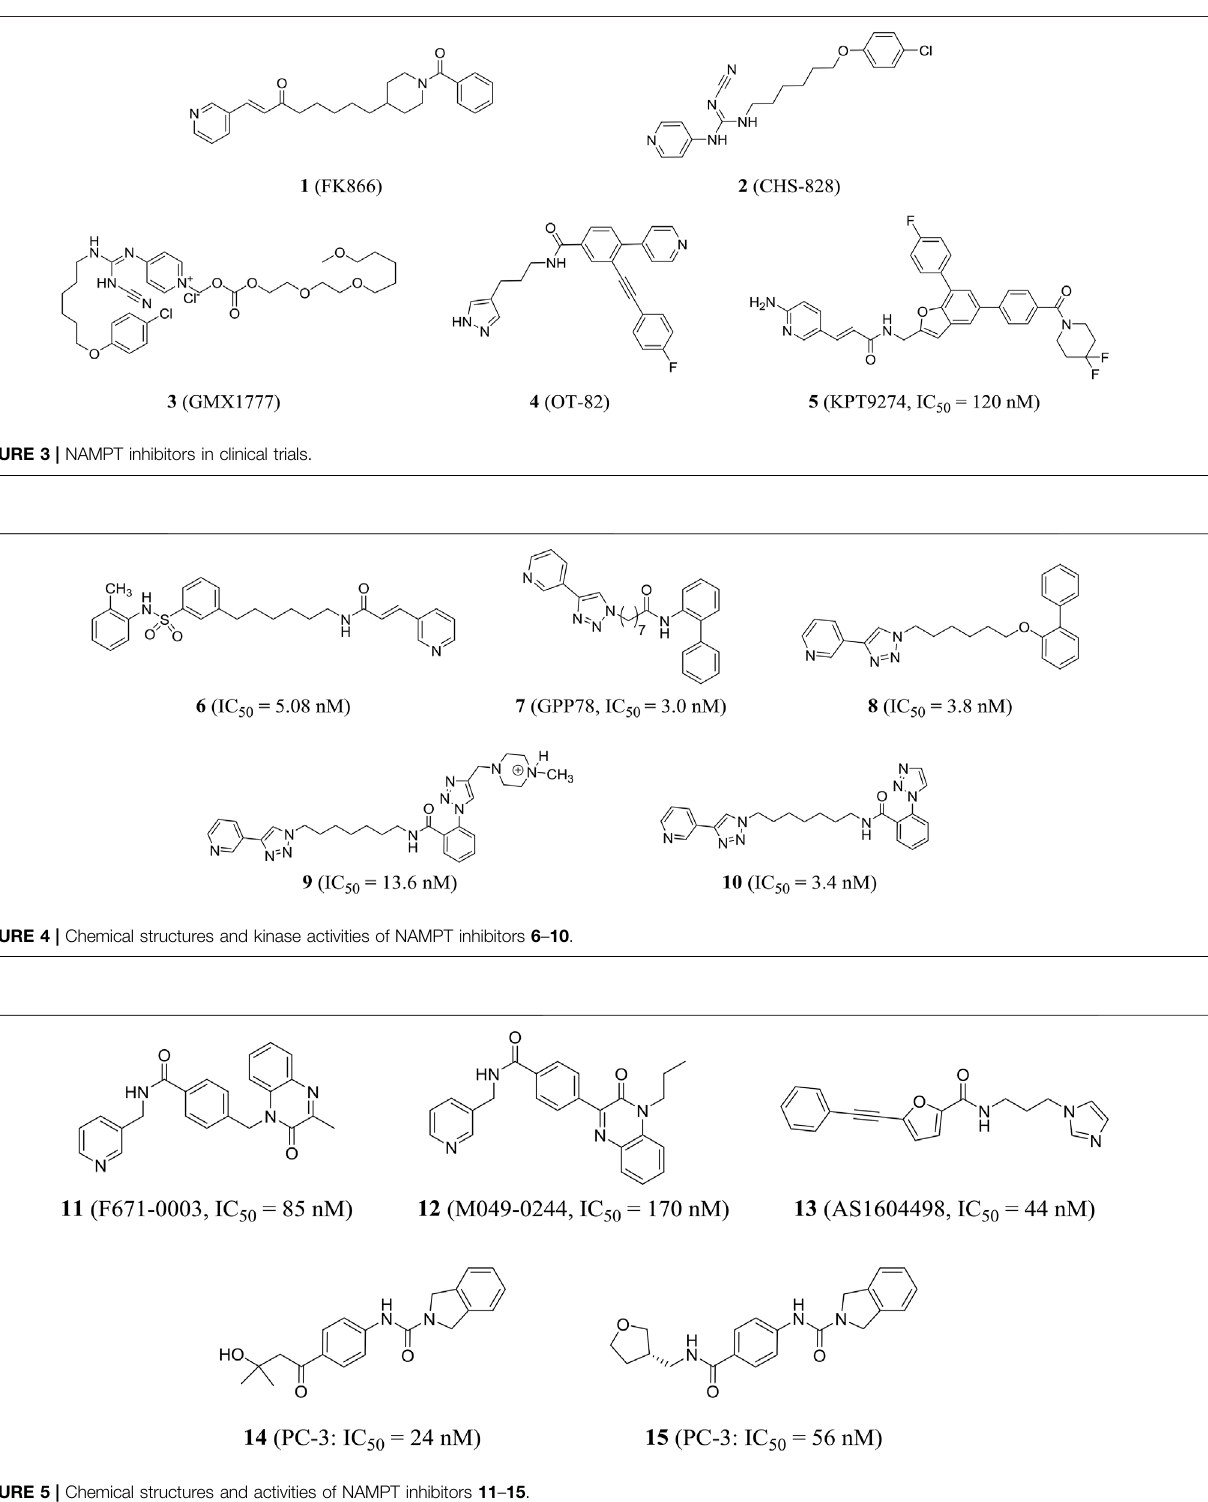
FIGURE 5 | Chemical structures and activities of NAMPT inhibitors 11 – 15